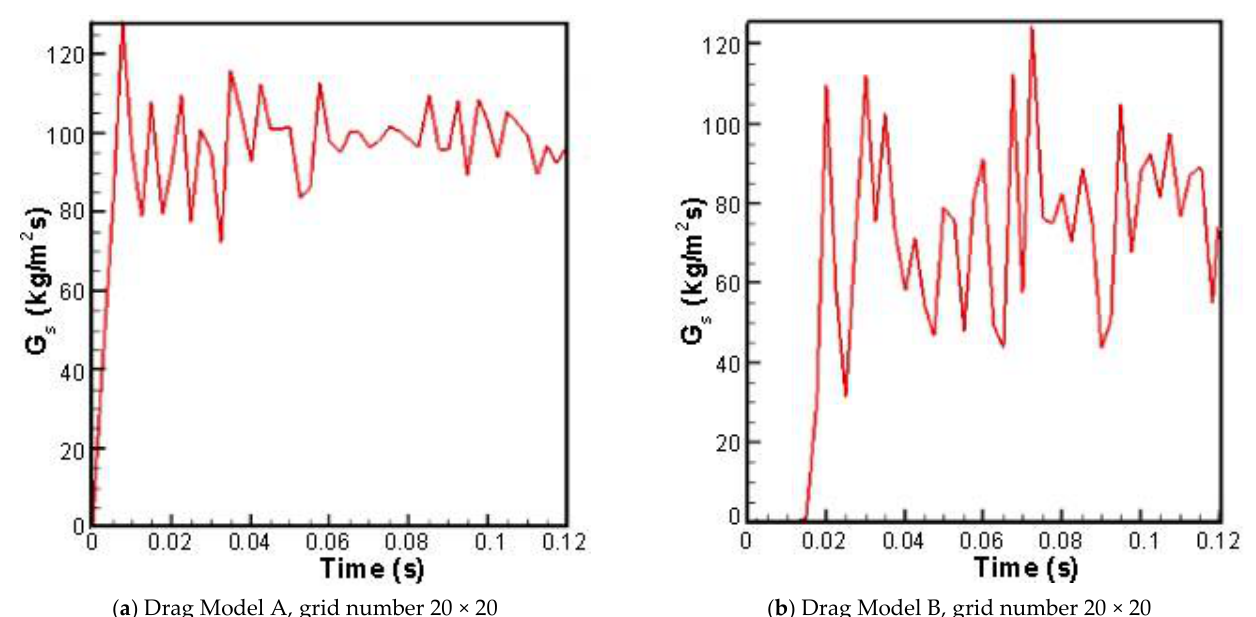
Figure 2. Outlet solid flux.